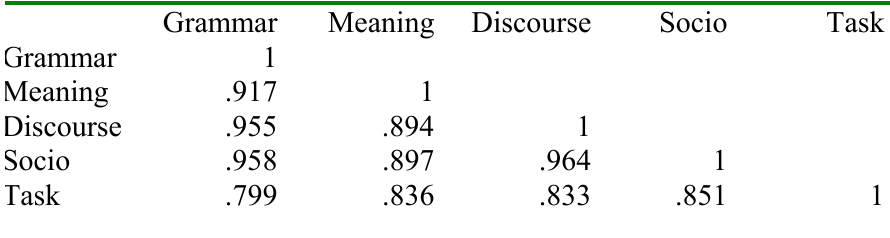
Correlation Analyses for the Low Proficiency Group